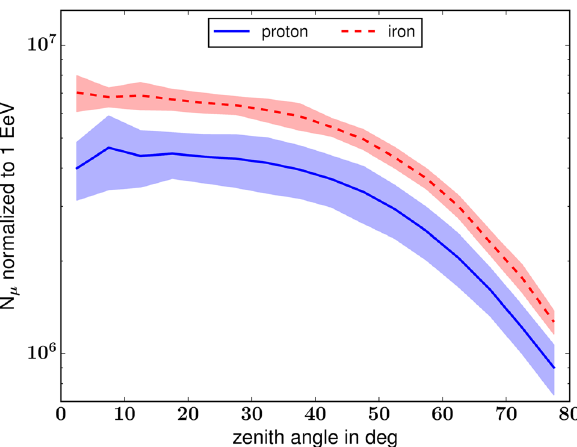
Fig. 1 Zenith angle dependence of the mean true number of muons at observation level (E μ > 1 GeV). The number of muons is normalized to an energy of 10 18 eV. For zenith angles larger than 40 ◦ the traveled distance becomes large and a fraction of the muons decays during the shower development before reaching the observation level of 1552 m a.s.l. As also in the following figures, the lines and their surrounding bands denote the mean values and the standard